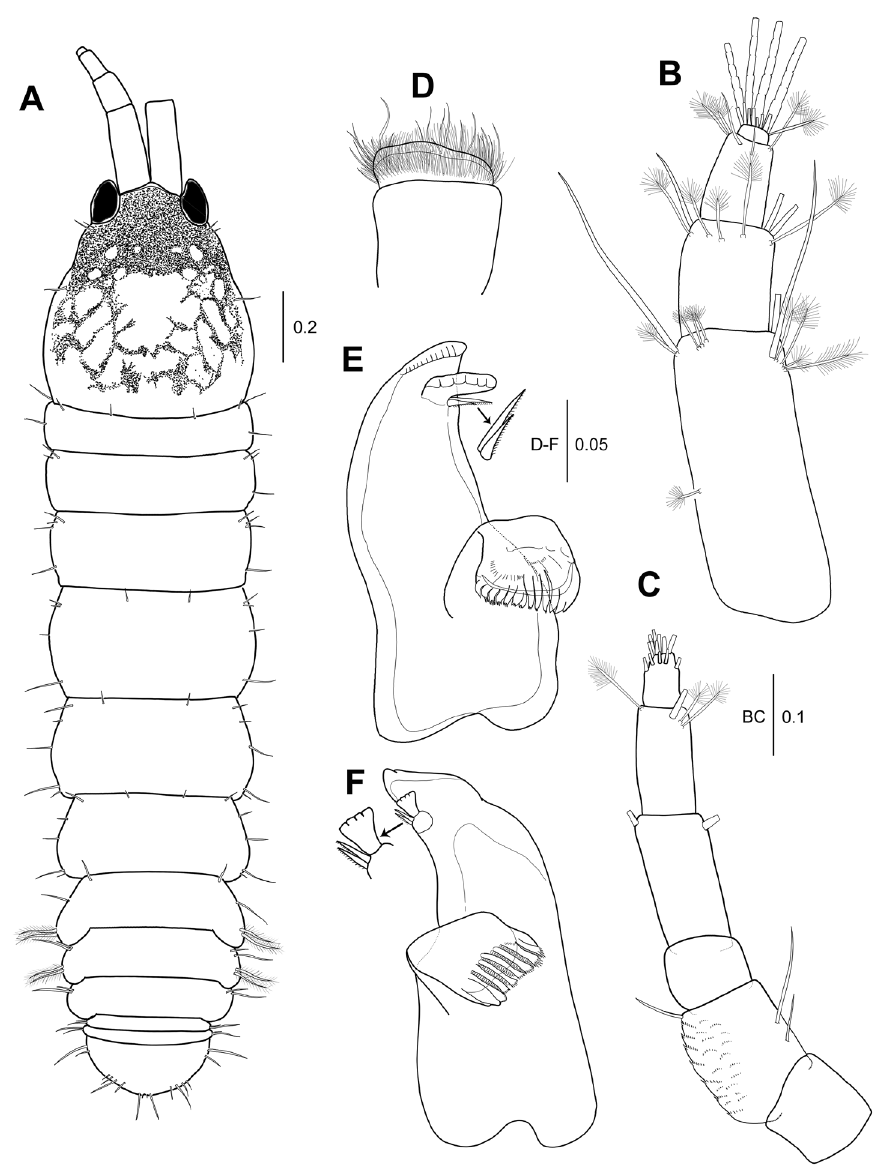
Figure 7. Hexapleomera ulsana sp. n., Jeju population, female, A habitus, dorsal, all pigmentations except that on carapace not presented B antennule C antenna D labrum E left mandible F right mandible. Scale bars in mm. gin. Article 3 1.5 times as long as wide, with five broom setae and two simple setae. Article 4 with seven simple setae, one broom seta, and four